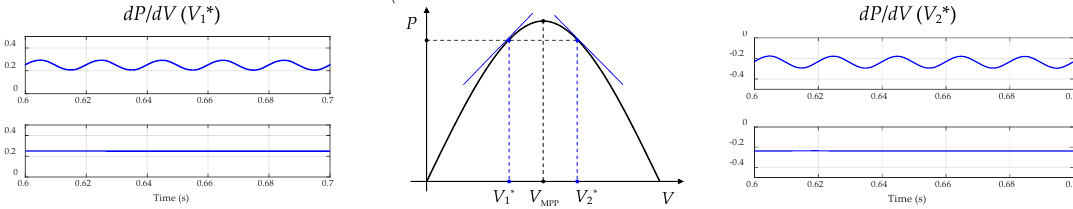
Figure 14. Simulation results: steady-state estimation of dP / dV by RCC with moving average over different periods and working points on the left ( V 1 * = 45 V) and on the right ( V 2 * = 55 V) of the MPP ( V MPP = 50 V). Top traces: MAvg over T /2 (100 Hz, basic RCC), and bottom traces: MAvg over T (50 Hz, modified RCC).